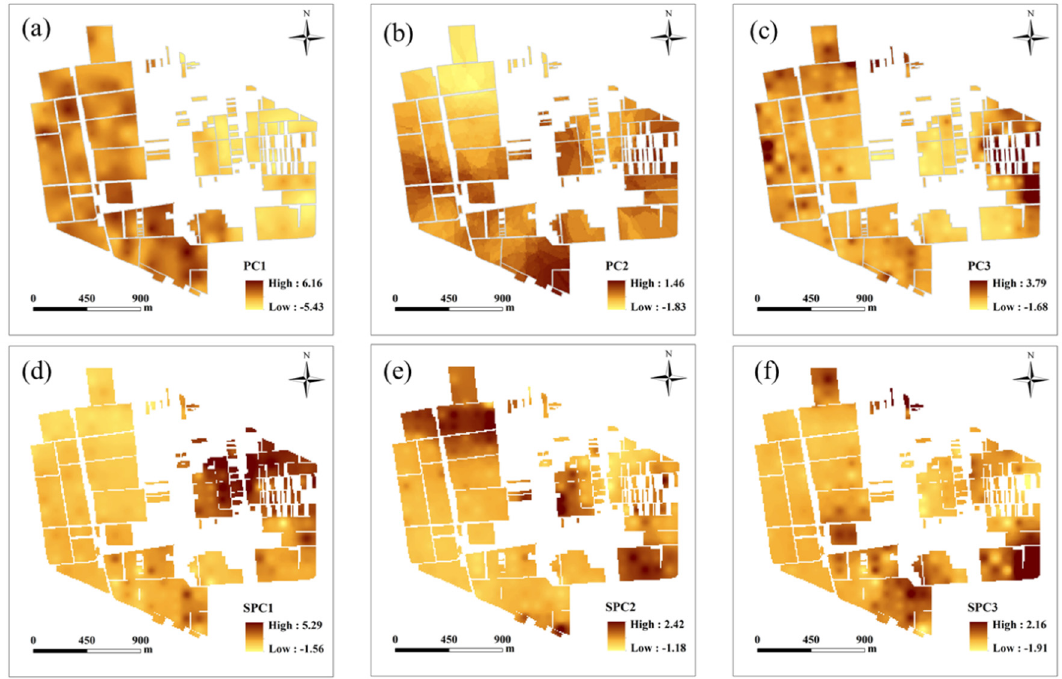
Figure 4. Spatial distribution maps of principal components (PCs) and spatial principal components (SPCs). ( a ): PC1; ( b ): PC1; ( c ): PC3; ( d ): SPC1; ( e ): SPC2; ( f ): SPC3. Table 4. Results of the evaluation of the clustering models in the generation of two, three, and four classes in terms of the ANOVA (Tukey’s test), variance reduction (VR) index, and average silhouette coefficient